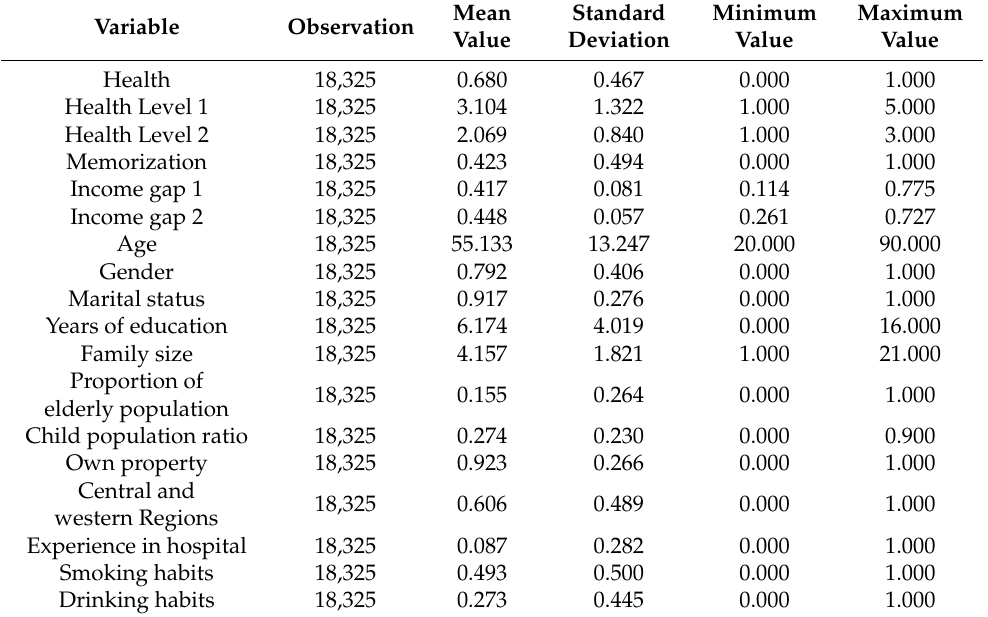
Table 2. Descriptive